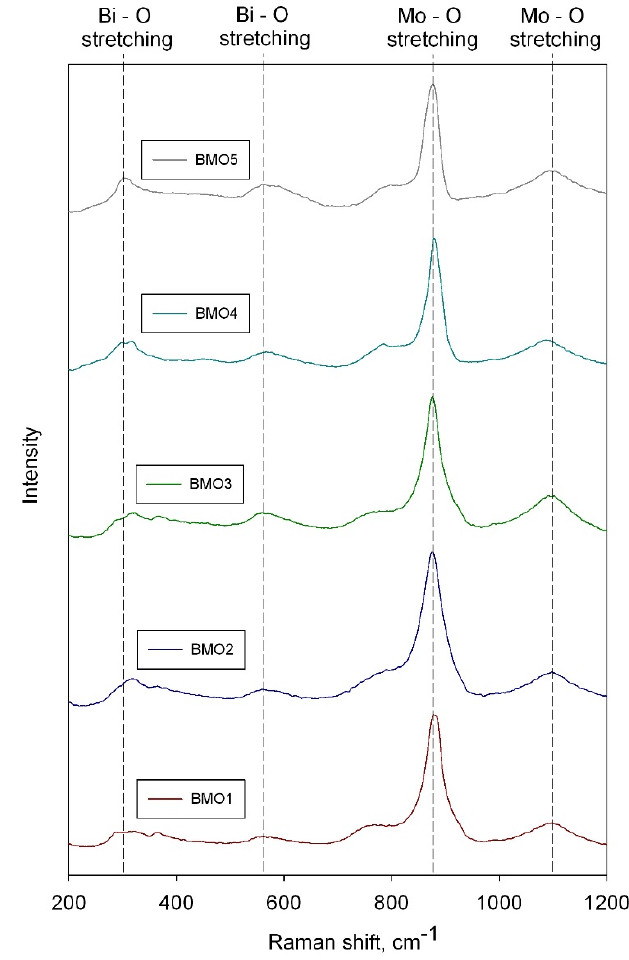
Figure 3. Results of Raman spectroscopy for bismuth molybdate coatings deposited onto glass substrates and annealed at 673 K.